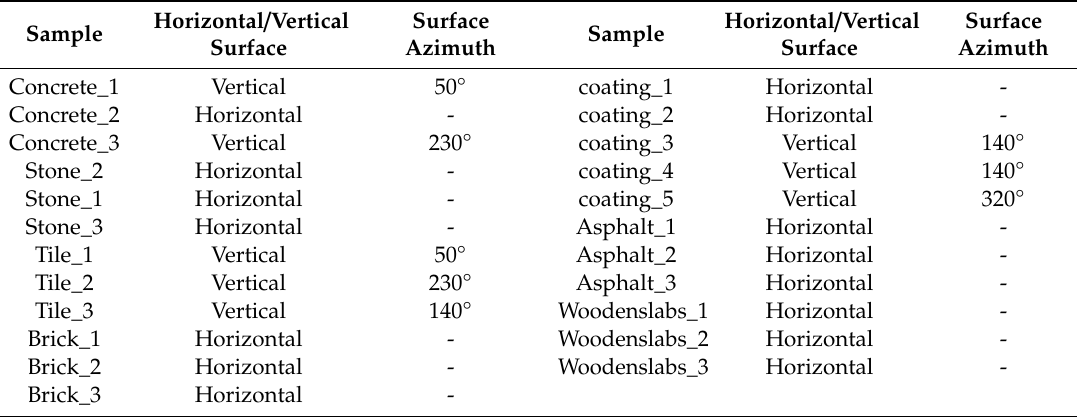
Table 3. Samples used for